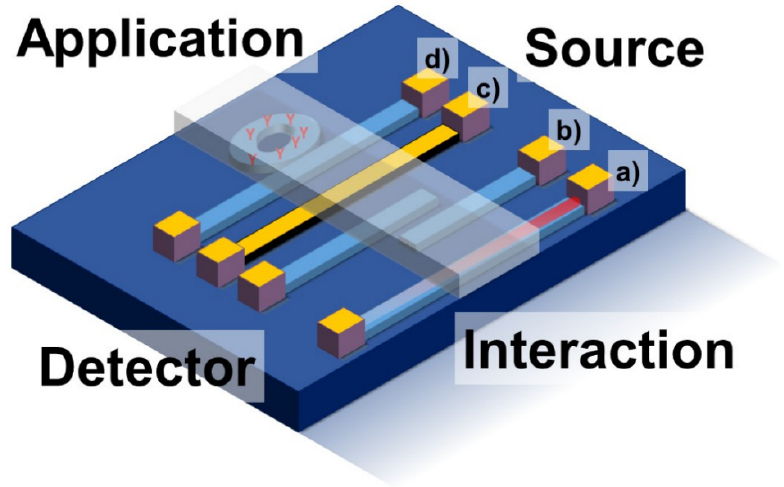
Figure 7. Conceptual design of infrared spectroscopy/sensor devices with a high level/on chip integration providing all necessary components hybridized or monolithically integrated onto a single chip-sized die derived from CMOS/IC technology. Such chip-scale devices can be realized, for example, via on-chip laser sources and detectors. Analyte interaction may be realized via various approaches including but not limited to evanescent field interaction via straight strip dielectric waveguides ( a ), more sophisticated waveguide structures such as slot, bimodal or MZI waveguides ( b ), plasmonic waveguides ( c ), or by using resonant cavities with the possible addition of analyte scavenging/enriching motifs ( d ). Defined sample-photon interaction may be realized via microfluidic channels or hollow structures accommodating gas/vapor, liquid or solid sample matrices, respectively.